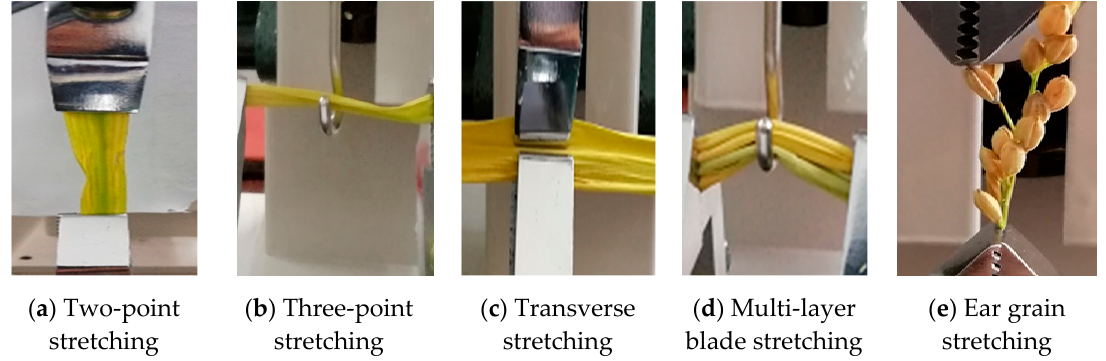
Figure 4. Tensile properties of rice leaves and grain.